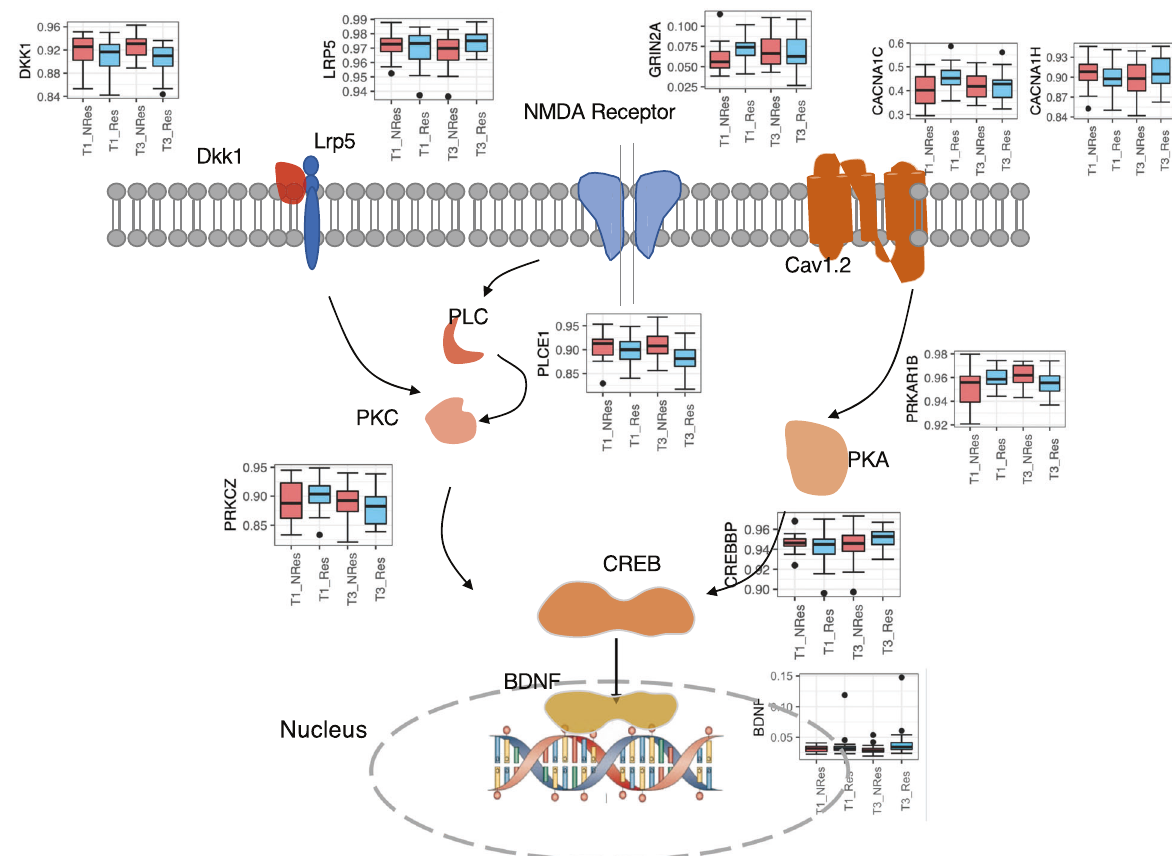
Fig. 2 The differentially methylated pathways, identi fi ed from the analysis of the DMPs, showed overlap in the Cav1.2-PKA-CREB and DKK1/ LRP5-PKC-CREB signaling pathway (nonresponder in red bar, responder in blue bar on the side